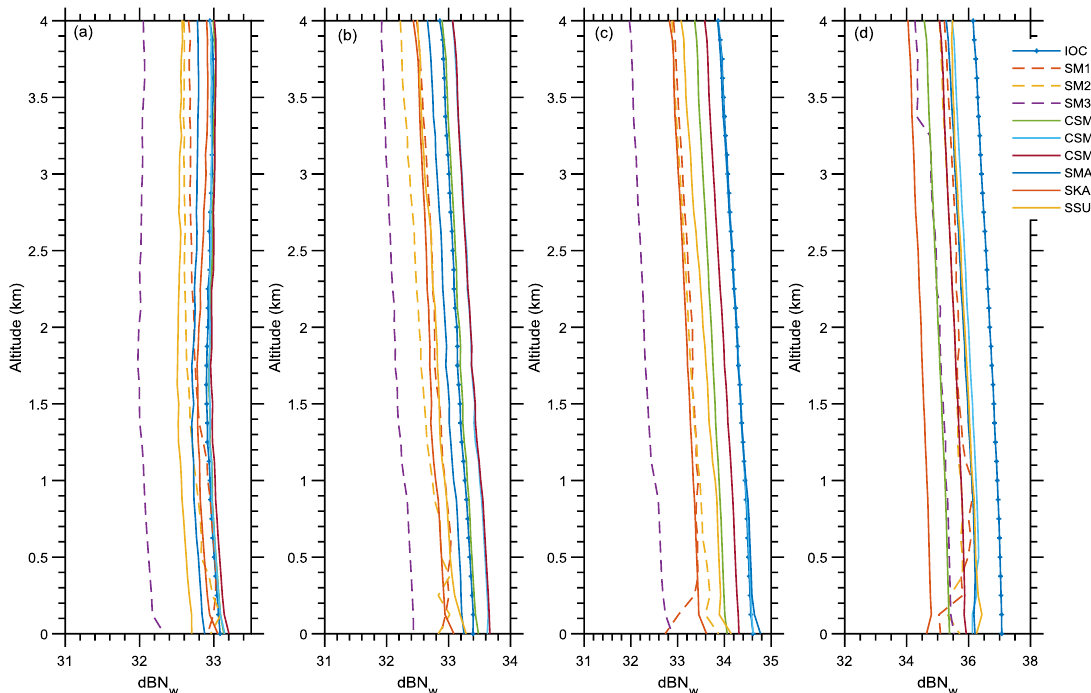
Figure 6. Vertical profile of total drop concentration (dB N w ) for ten selected locations of stratiform rain for a) very light rain, b) light rain, c) moderate rain, and d) heavy rain.